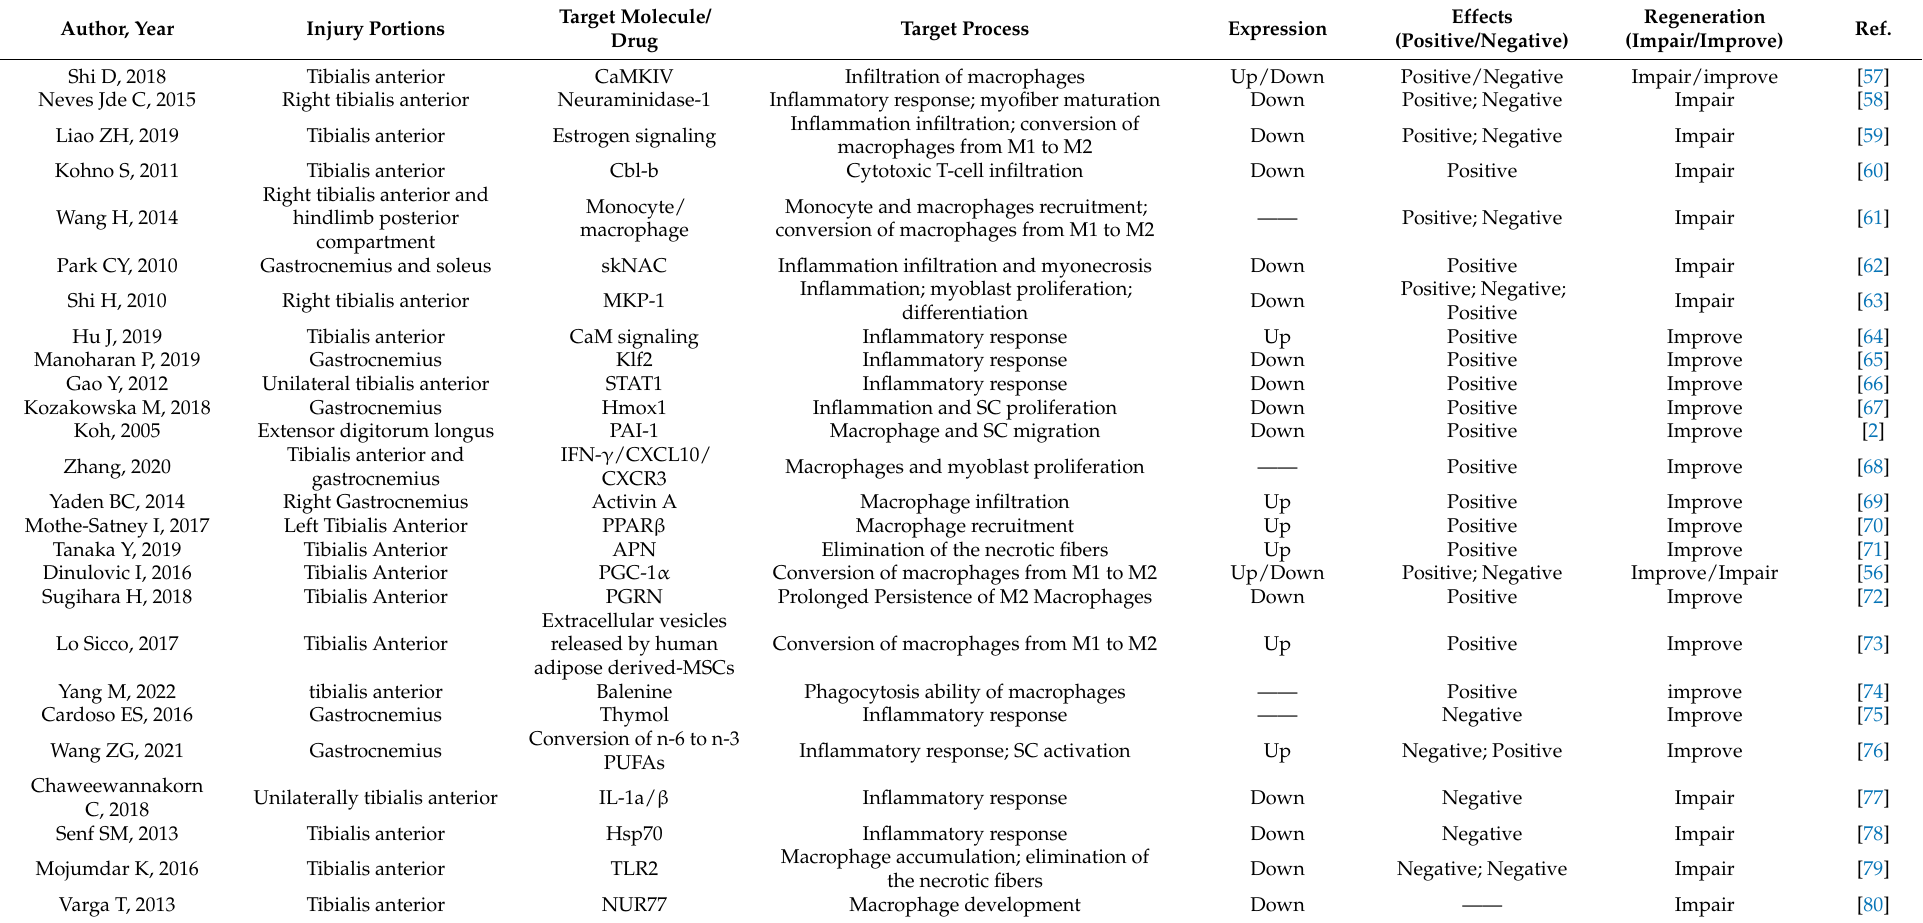
Table 2. The mechanism of inflammatory infiltration, conversion of macrophages, and elimination of the necrotic